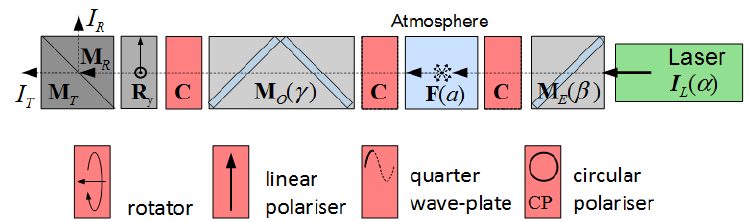
Figure 2. Schematic of a two-channel, polarisation-sensitive lidar setup (compare Fig. 1) with Müller matrix block elements and different calibrator (red block) positions (top), and three options for the calibrator C (bottom). I L : laser Stokes vector, M E : emitter optics; F : atmospheric backscatter matrix with polarisation parameter a; M O : receiver optics; R y : rotation matrix for the 0° (y=+1) and 90° (y=-1) detection setup (see text); M T,R : transmitted and reflected part of the polarising beam splitter; I T,R : transmitted and reflected detection signals. Angles α, β, and γ are rotations around the optical